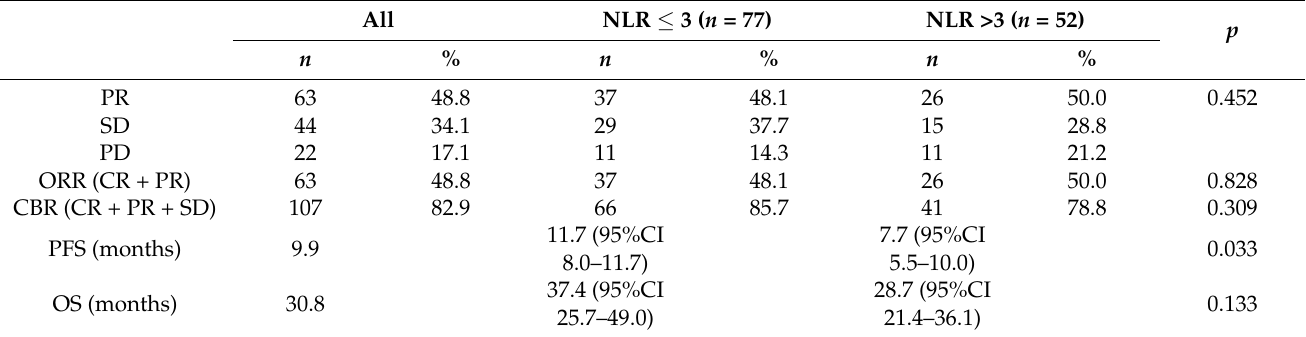
Table 2. Correlations between baseline NLR and treatment outcomes in patients with MBC.